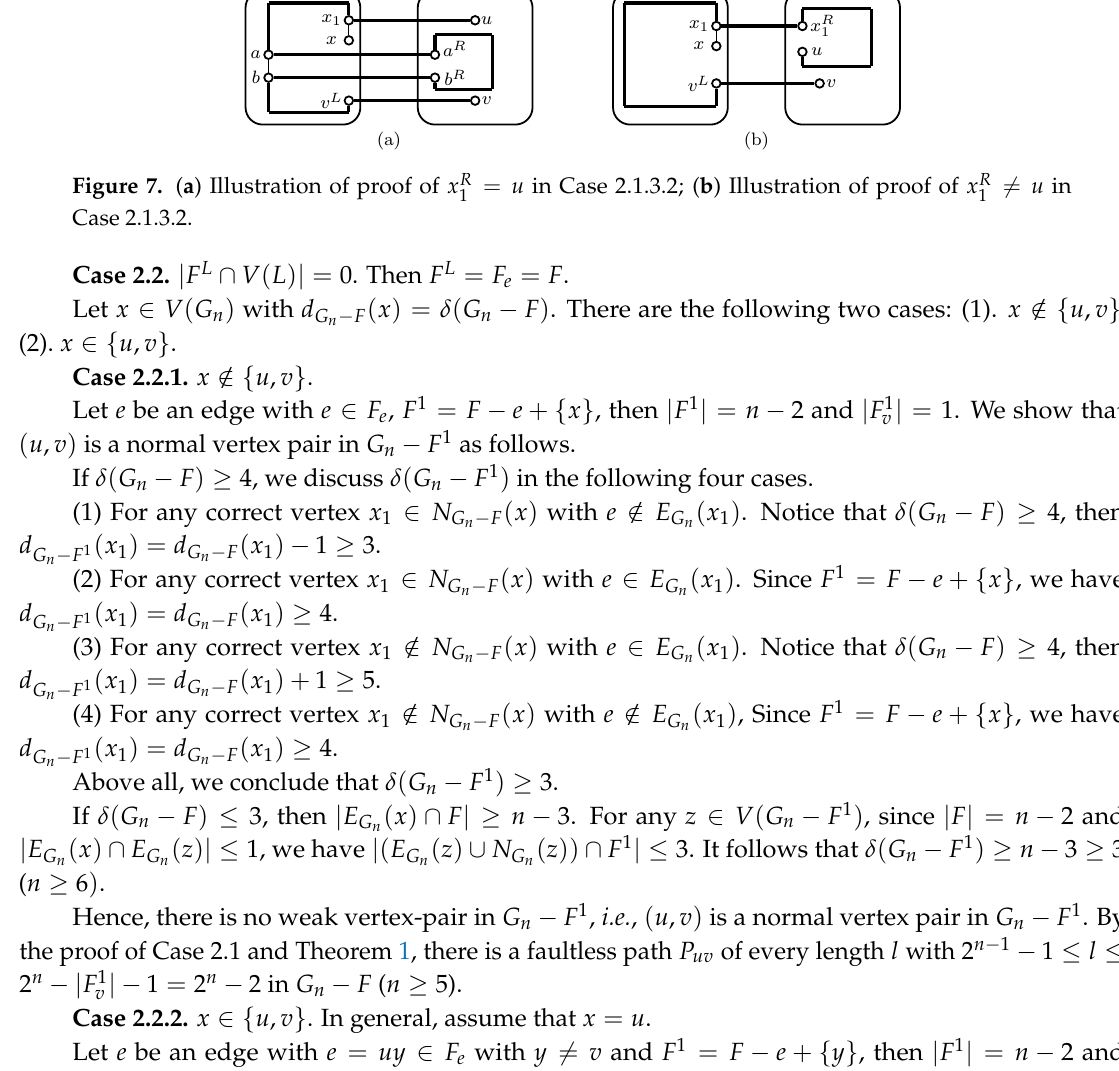
= u in Case 2.1.3.2; ( b ) Illustration of proof of x R 1